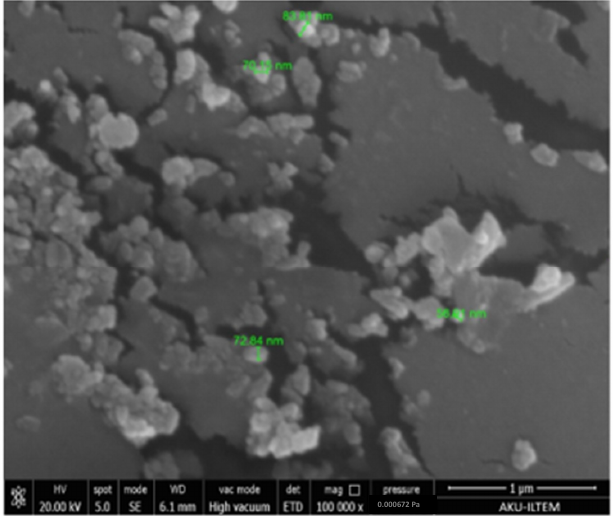
0.000672 Pa Figure 2. Image of scanning electron microscope (SEM) for the biosynthesized nanoparticles.